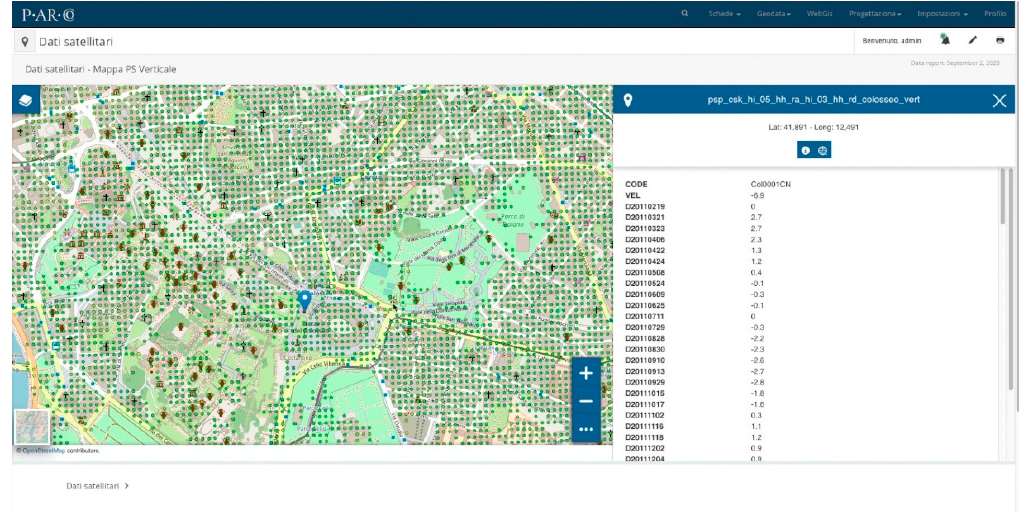
Figure 6. SyPEAH, satellite map.